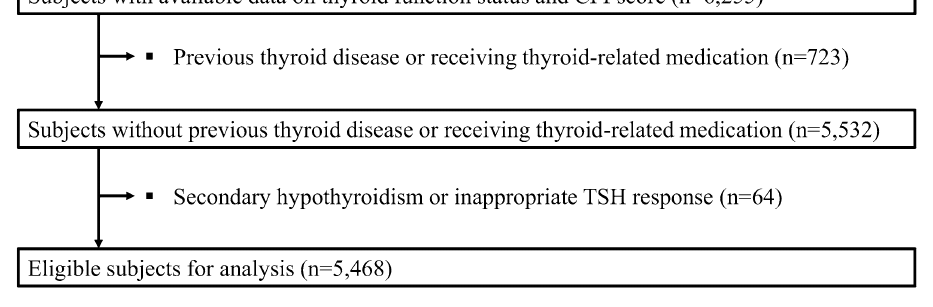
Figure 1. Flow chart of participants included in the study. Abbreviations: CPI: Community Periodontal Index; KHANES, Korea National Health and Nutrition Examination Survey; TSH: thyroid-stimulating hormone.